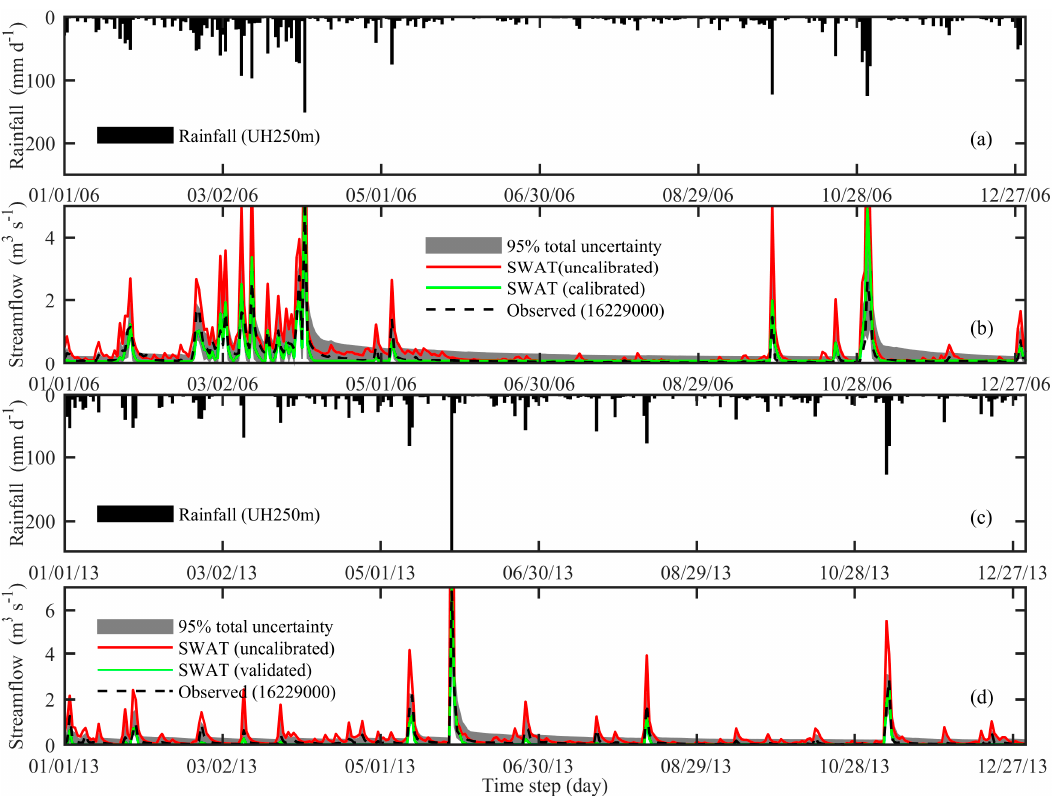
Figure 6. ( a ) Daily UH250m rainfall of 2006 and ( b ) the respective observed and simulated daily streamflows at USGS gauging #16229000 (calibration period); and ( c ) daily UH250m rainfall of 2013 and ( d ) the respective simulated and observed daily streamflows (validation period) for Kalihi sub- watershed.